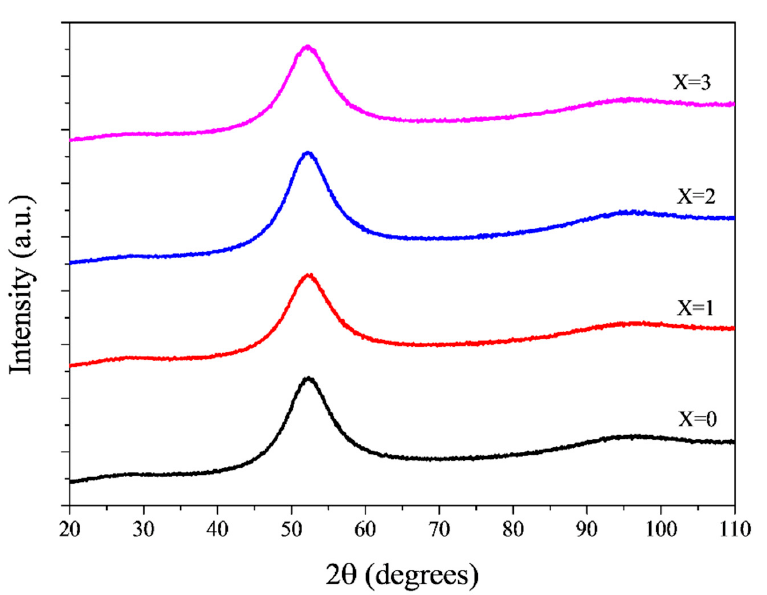
= 0, 1, 2 and 3) ribbons.